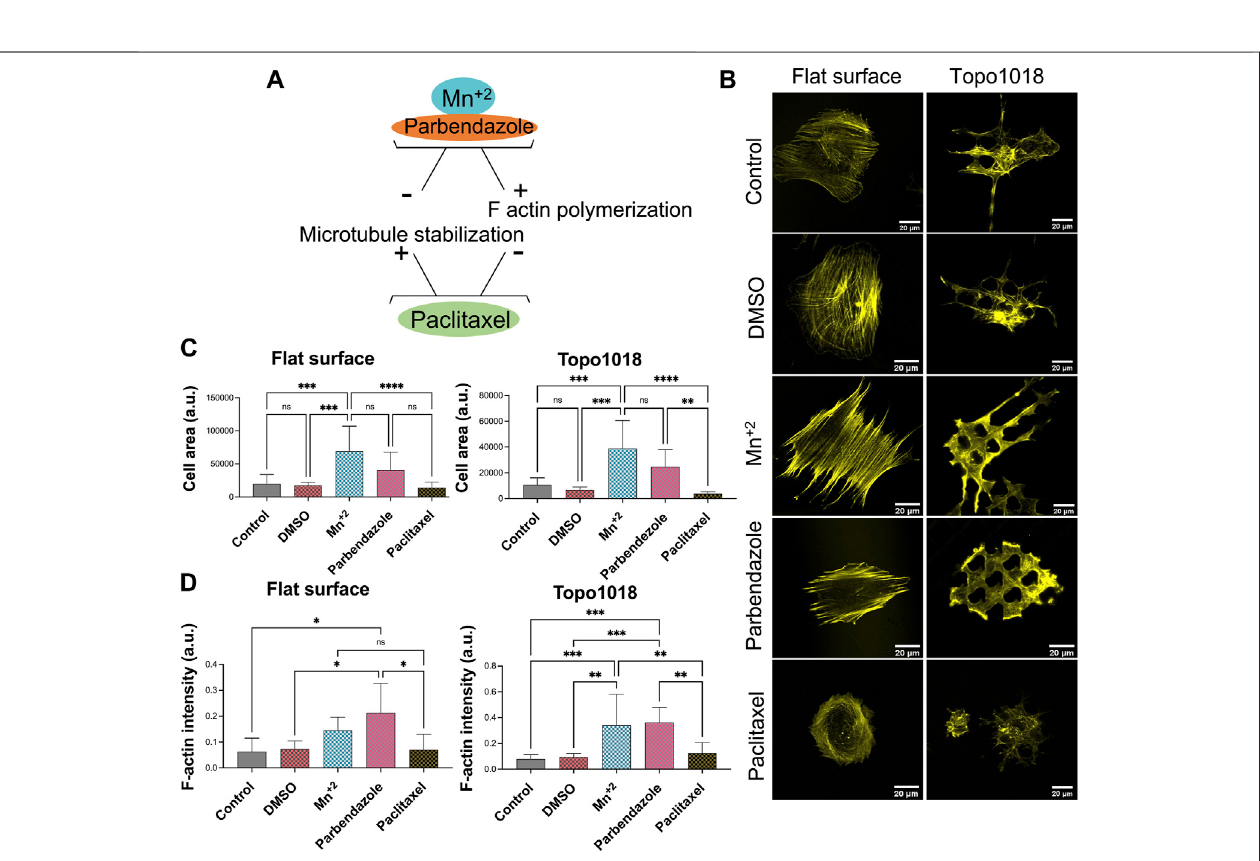
FIGURE 7 | Small molecules that in fl uence integrin signaling, actin polymerization, and microtubule stability affected the actin cytoskeleton. (A) Illustration of the action mechanism of the small molecules used in this study: Mn 2+ to activate integrin signaling and induce F-actin polymerization, parbendazole to induce F-actin polymerization and degradation of microtubules, paclitaxel to compromise F-actin polymerization and stabilize microtubule assembly [ (B) - Left panel] Treatment with Mn 2+ and parbendazole increased the thickness of the ventral stress fi bers while paclitaxel treatment lead to the formation of thinner stress fi bers compared to control groups. Scale bars represent 20 µM. [ (B) -Right panel] On the Topo1018 surface, similar to the fl at surface, we observed that stress fi bers become thicker, and cellsattachedtothebottomofthesurfaceuponMn 2+ andparbendazoletreatment.Scalebarsrepresent20 µM. (C) Quanti fi cationofthecellareaofcellsculturedonthe fl at and Topo1018 surfaces and treated with small molecules. (D) Quanti fi cation of F-actin intensity of cells cultured on the fl at and Topo1018 surfaces and treated with small molecules. (Error bars represent 95% con fi dence intervals, * p < 0.05, *** p < 0.005). For all experiments, N = 3.